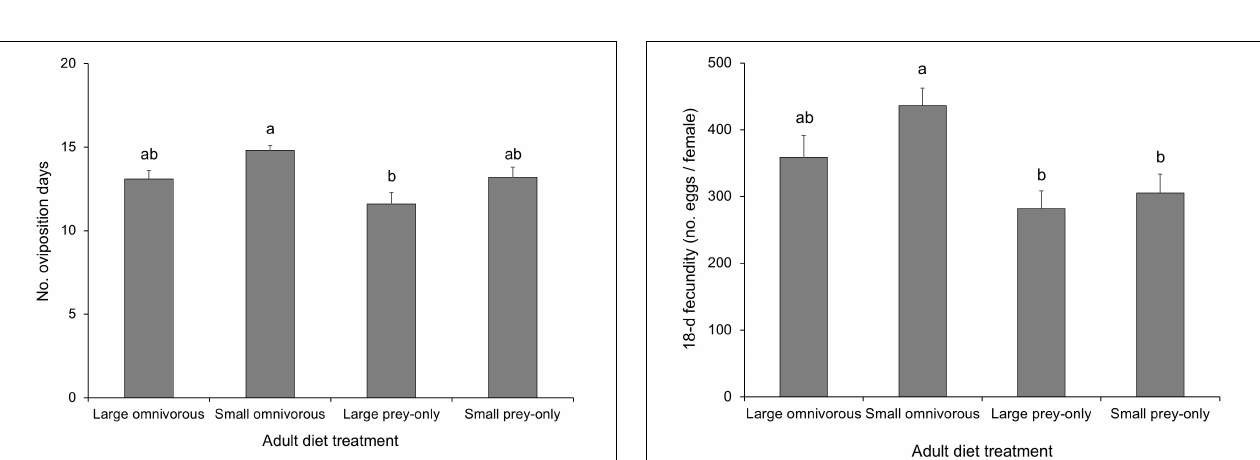
FIGURE 1 | Mean (+ SE) preoviposition periods, of large ( ad libitum larval food access) and small (3 h daily larval food access) Hippodamia convergens pairs subjected to one of two different adult diet treatments: omnivorous (pollen, honey, Schizaphis graminum and Ephestia kuehniella eggs), or prey-only ( S. graminum and E. kuehniella eggs). Treatments bearing the same letter were not significantly different (Tukey’s test, α = 0.05).